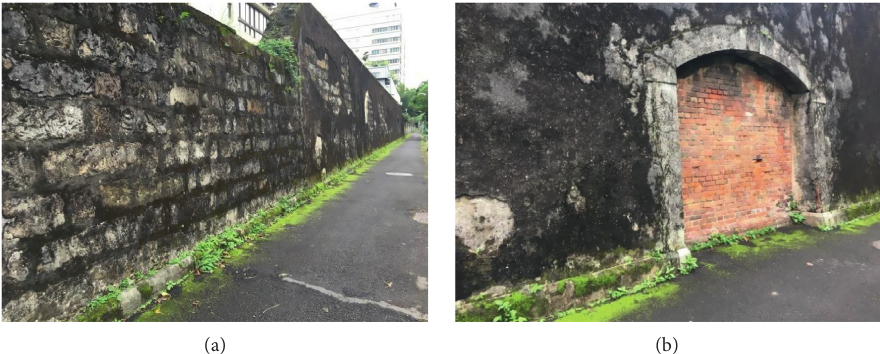
Figure 4: The remains of the Taipei prison wall. Source: Photos by Shuhui Lin; time: December 2, 2017; location: Lane 44, Section 2, Jinshan South